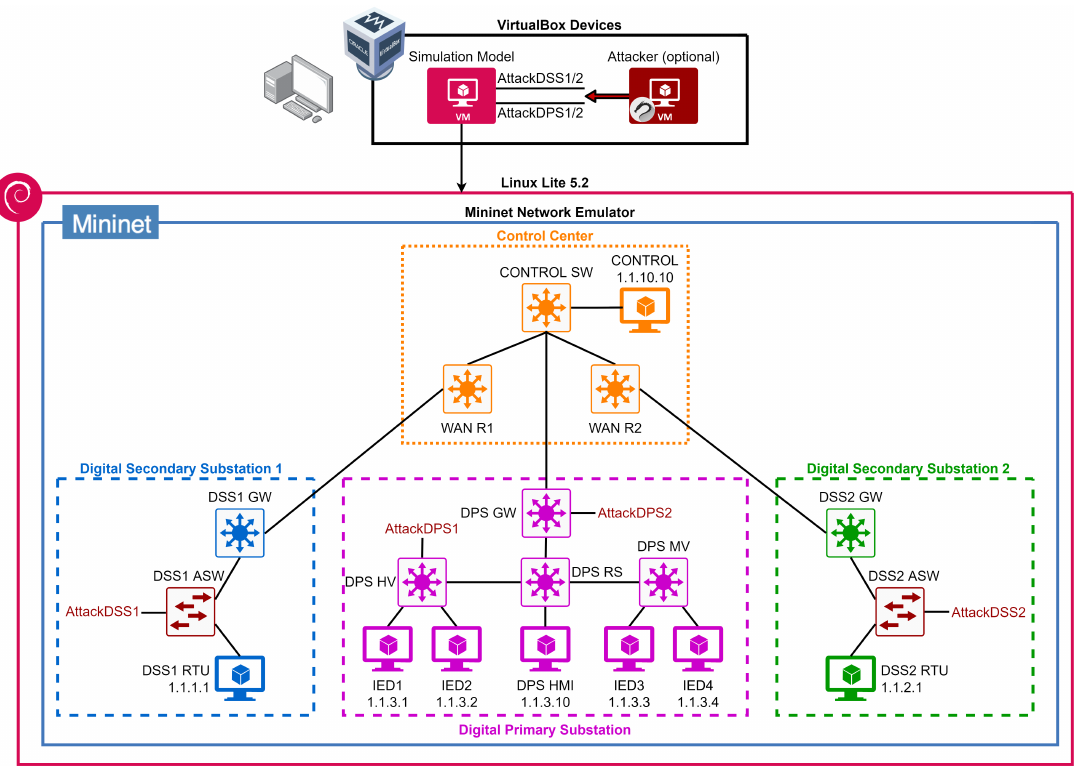
Figure 6. Impact Simulation